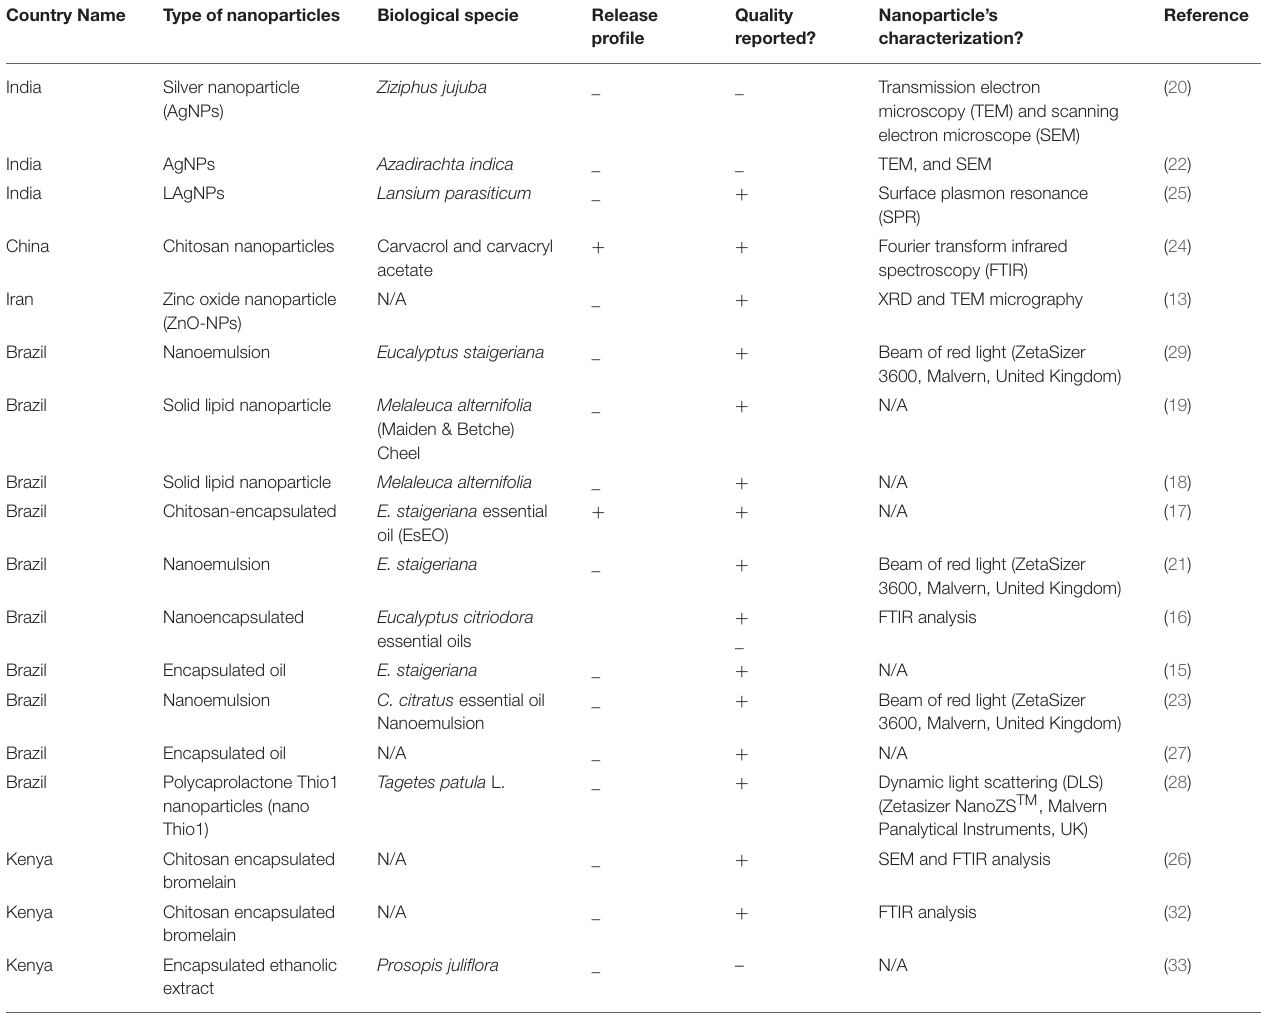
TABLE 1 | Quality assessment of articles selected for this systematic